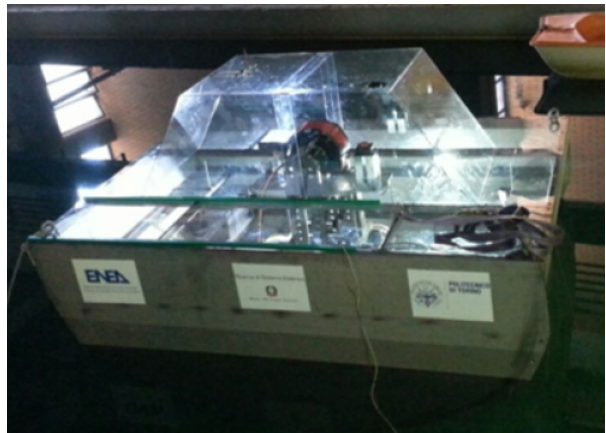
Figure 3. Photo of the 1:12 PeWEC prototype tested a wave tank